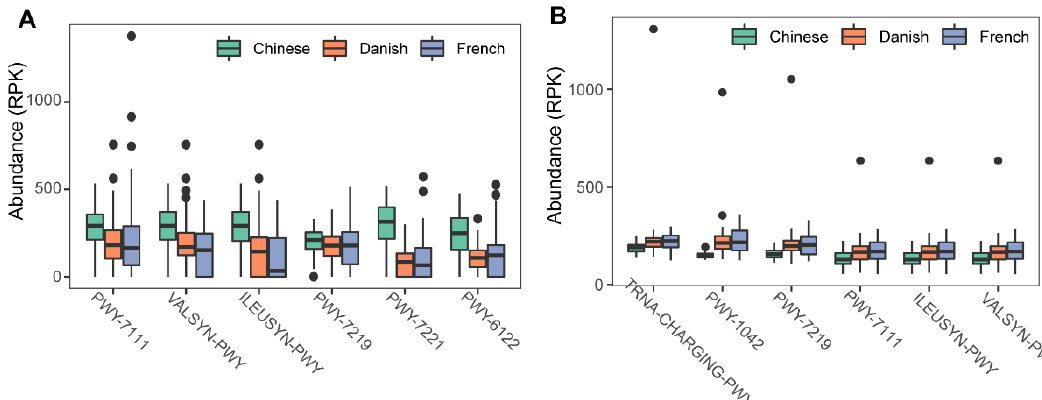
Figure 4. Summary of the predominant MetaCyc pathways of archaea and bacteria in pigs. The top six most abundant MetaCyc pathways of archaea ( A ) and bacteria ( B ) are displayed. In ( A ) and ( B ), the y -axis represents the number of reads mapped to reference genes involved in pathways. Data have been normalized to RPKM (reads per kilobase of transcript per million mapped reads).